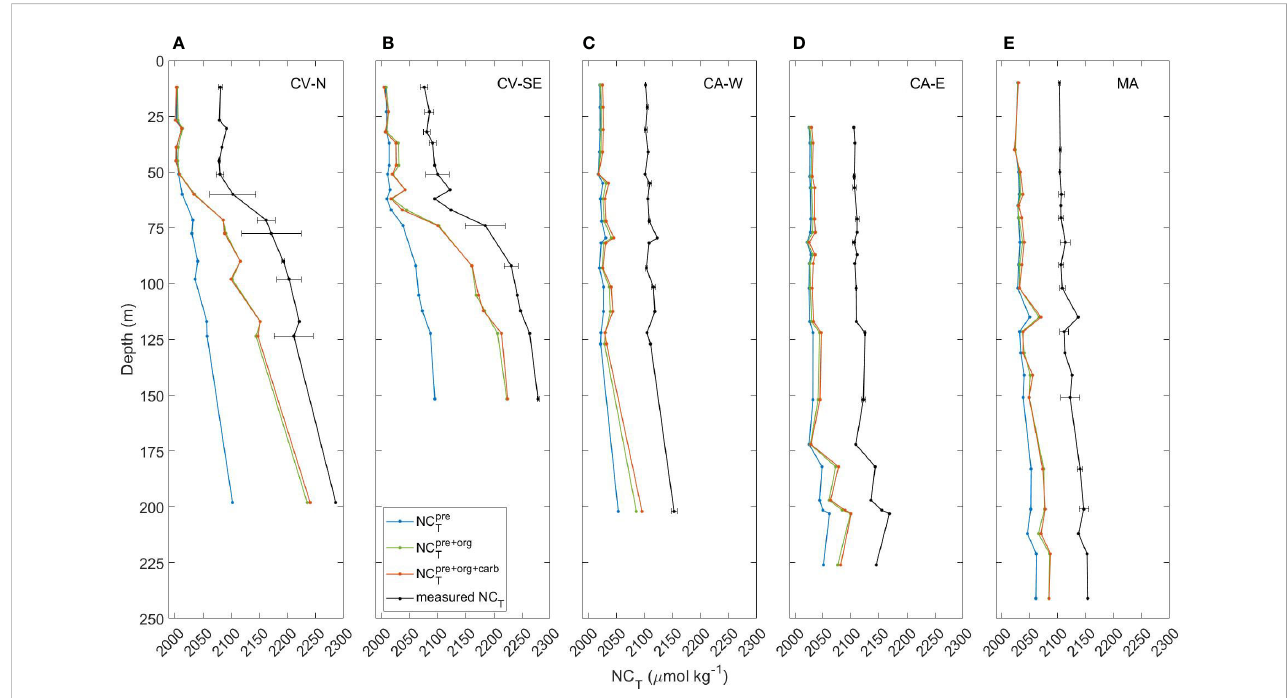
FIGURE 6 Upper ocean distribution (up to 250 m depth) of preformed NC T (NC Tpre ), its changes explained by the anthropogenic carbon (C ant ) and both the organic and carbonate pumps (NC Torg and NC Tcarb , respectively) and the determined NC T values in (A) CV-N, (B) CV-SE, (C) CA-W, (D) CA-E and (E) MA.